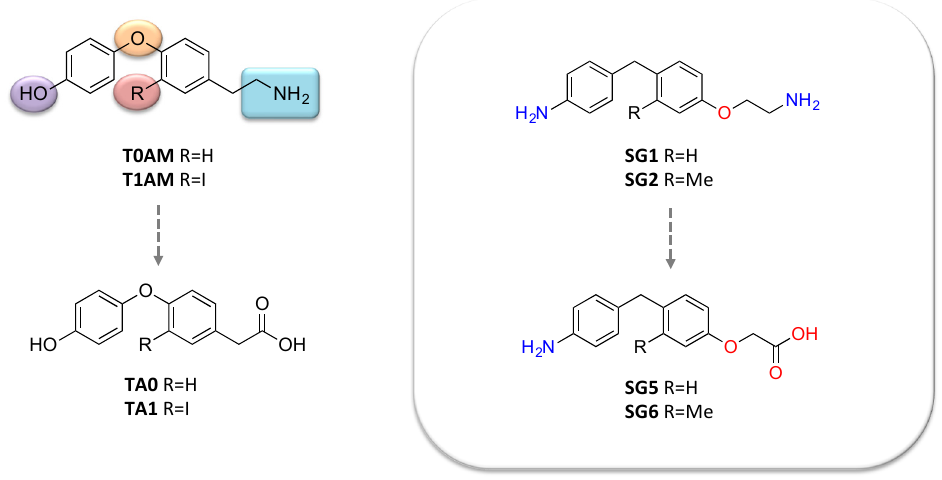
Figure 4. Chemical structures of endogenous thyronamines (T0AM, T1AM), their metabolites (TA0, TA1) and synthetic thyronamine-like derivatives (SG-1, SG-2; SG-5,